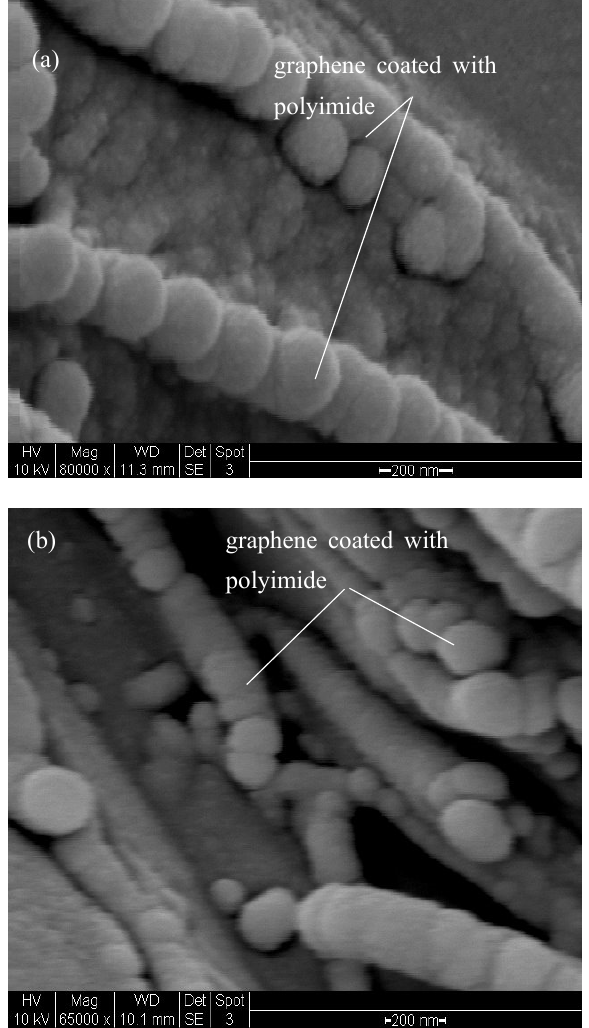
Figure 3. SEM micrographs showing cross-sectional morphology of ( a ) PINGS-30 and ( b ) PINGS-40.